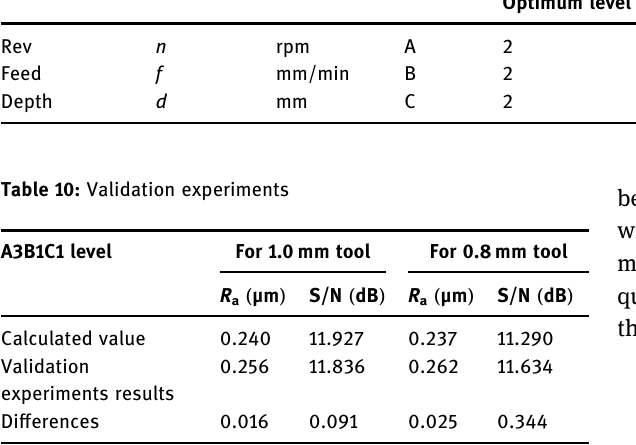
Table 9: Optimum levels for surface roughness Parameters